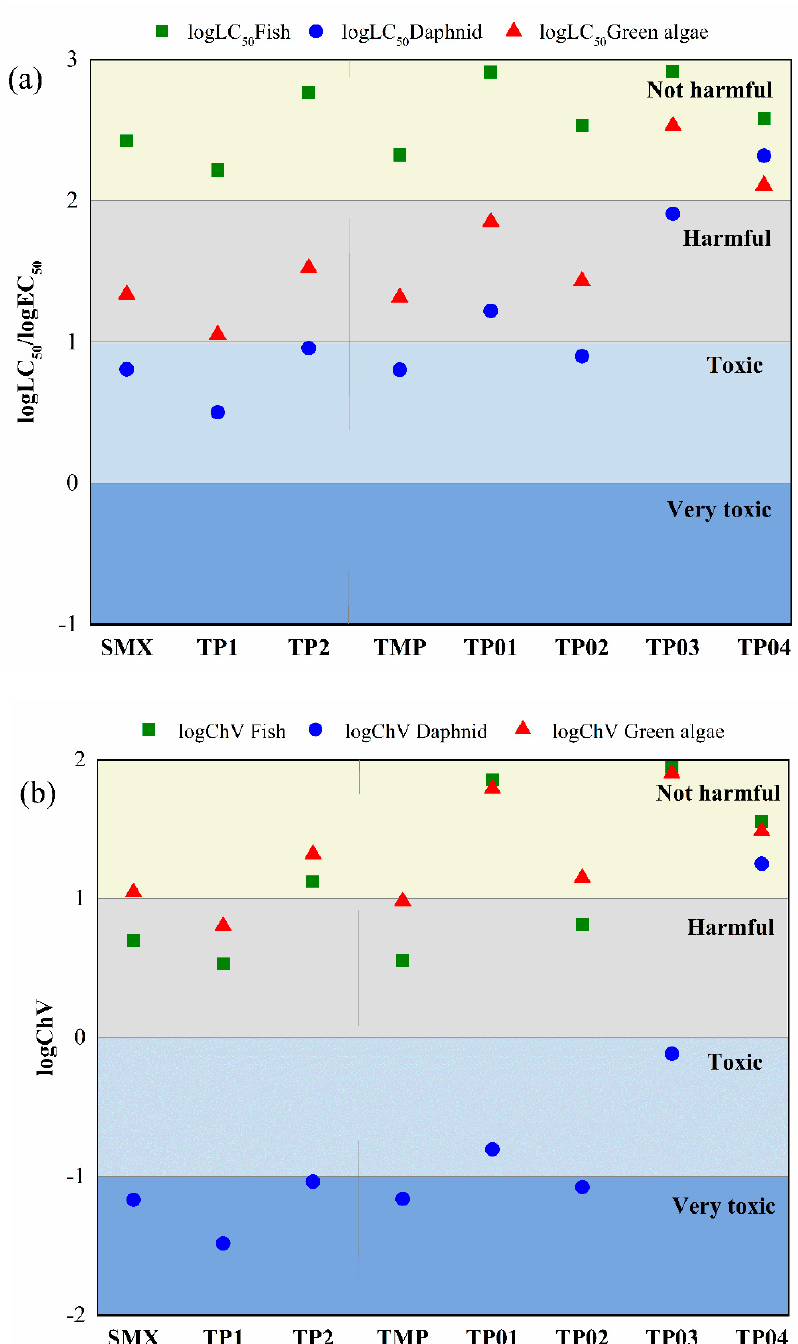
Figure 7. Acute toxicity ( a ) and chronic toxicity ( b ) (unit: mg L − 1 ) of SMX and TMP and their transformation products.